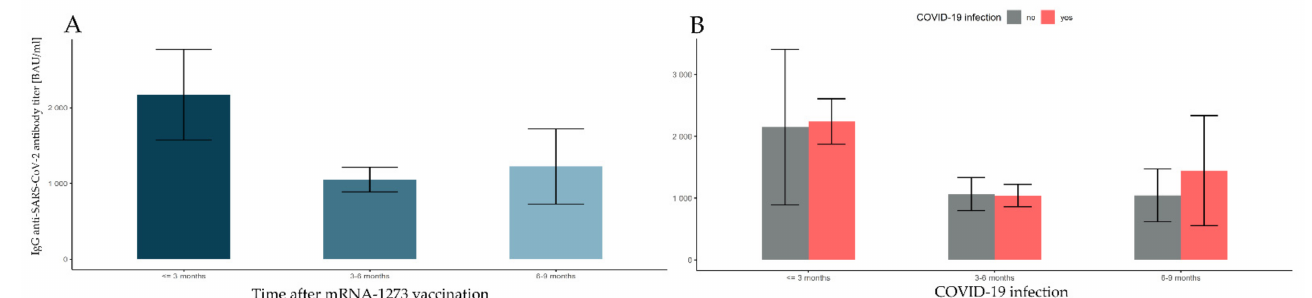
Figure 5. Comparisons of antibody levels following full vaccination with mRNA-1273, taking into account the time factor and the incidence of SARS-CoV-2 infection. The error bars for marginal means with 95% confidence intervals (bootstrapped) are presented in turn: ( A ) the time elapsed after the full mRNA-1273 vaccination; ( B ) the prior COVID-19 infection group with different time intervals elapsed after full mRNA-1273 vaccination.